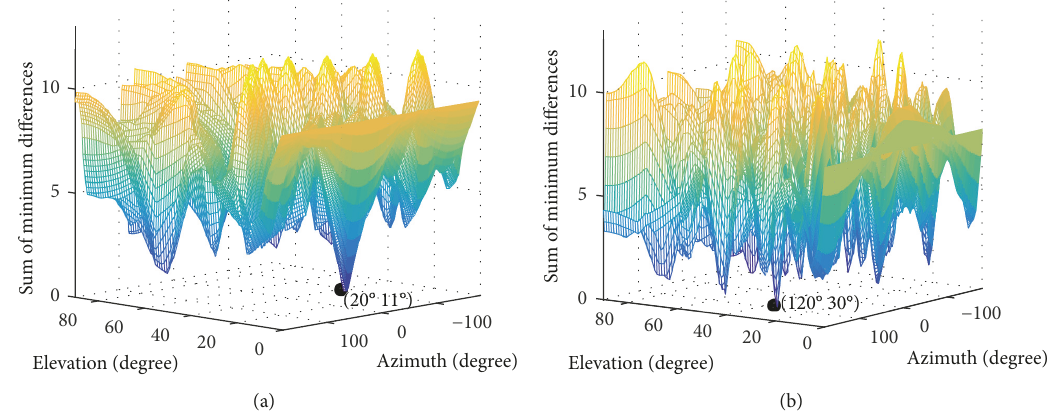
Figure 7: Sum of minimum difference. (a) Source 1. (b) Source 2.